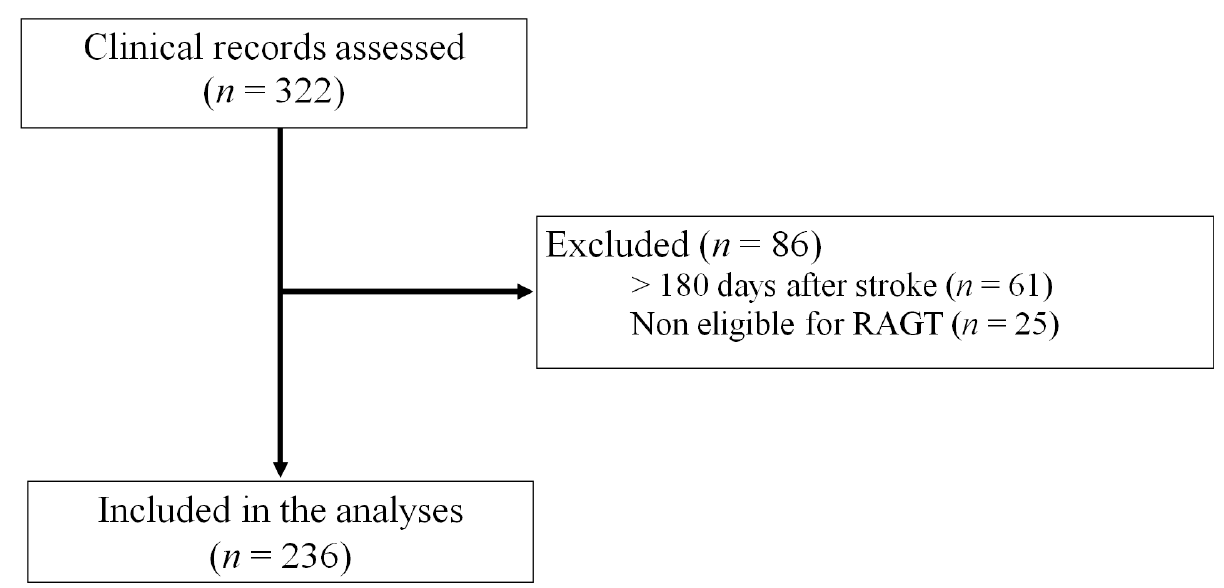
Figure 1. Flow diagram of participants.